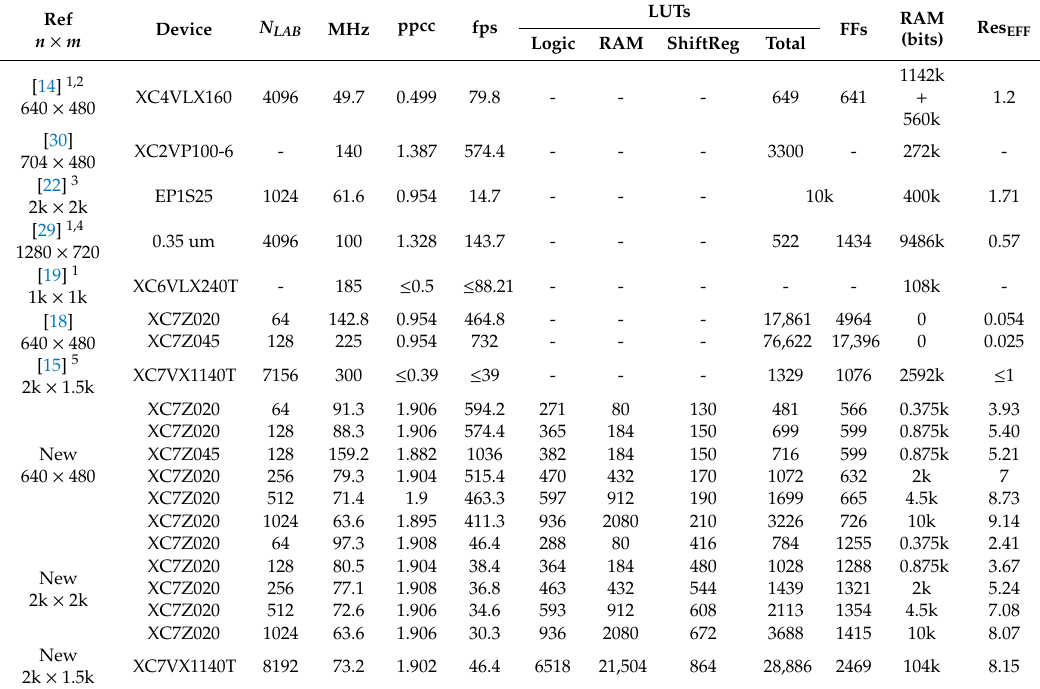
Table 3. Comparison